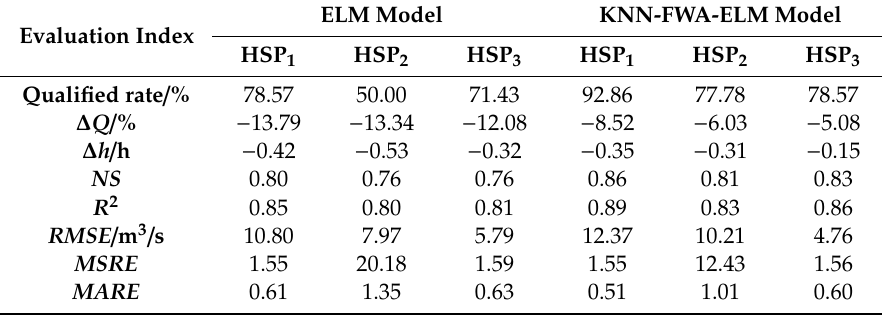
Table 6. Comparison of all flood simulation results in di ff erent